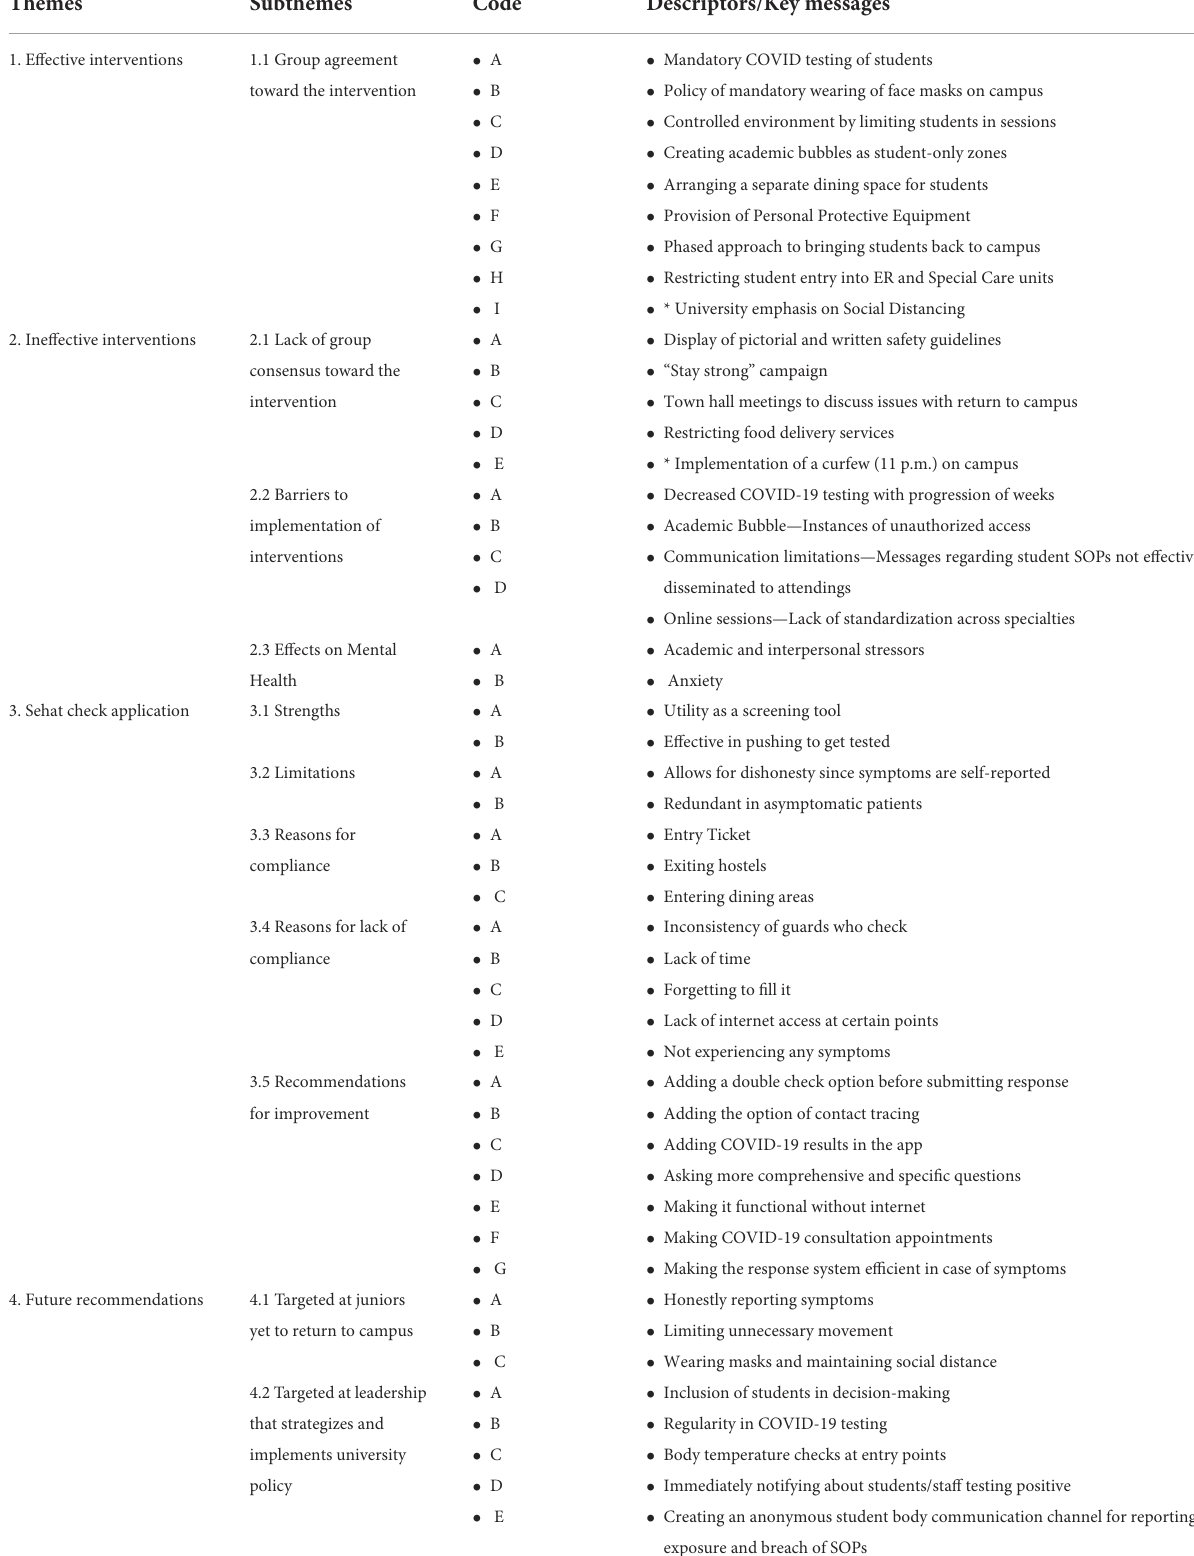
TABLE 2 Thematic analysis of focused group discussions with themes, sub-themes, codes, and key messages.